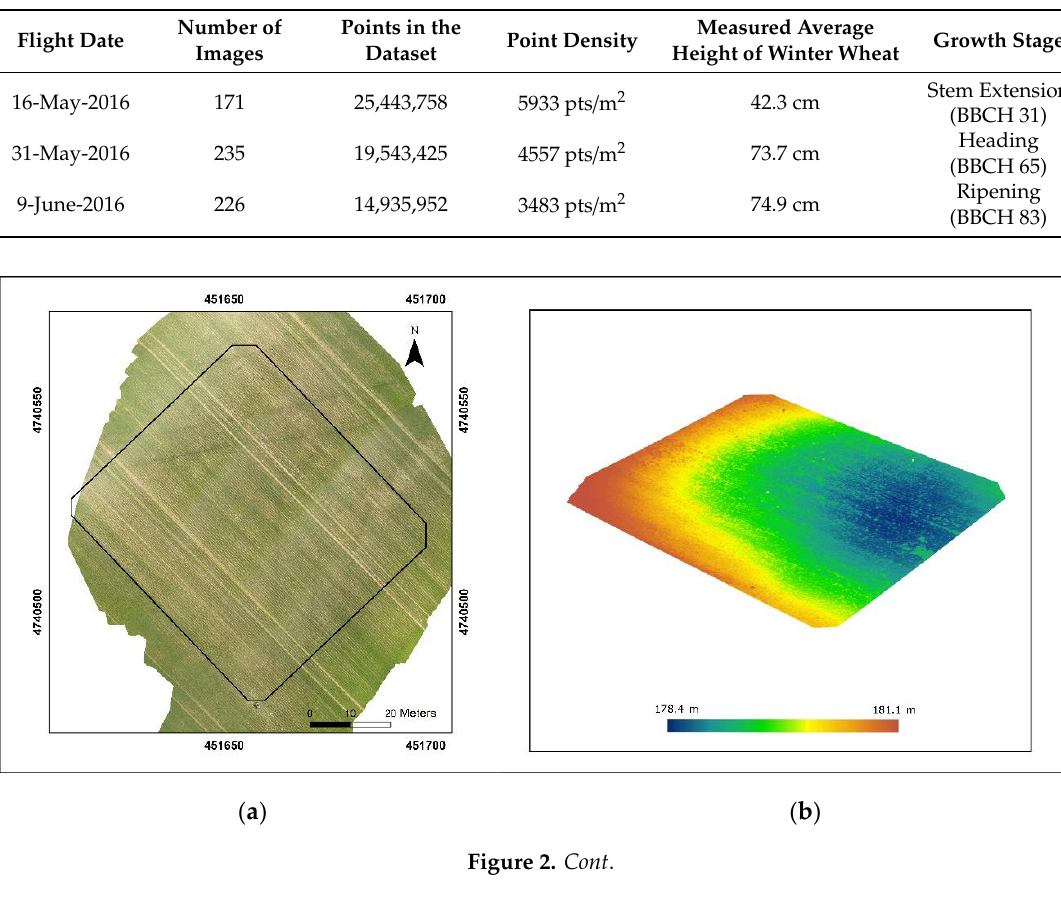
Table 1. Unmanned Aerial Vehicle (UAV) flight dates, number of images, points in the dataset, point density, average ground measurements, and winter wheat growth phenology.